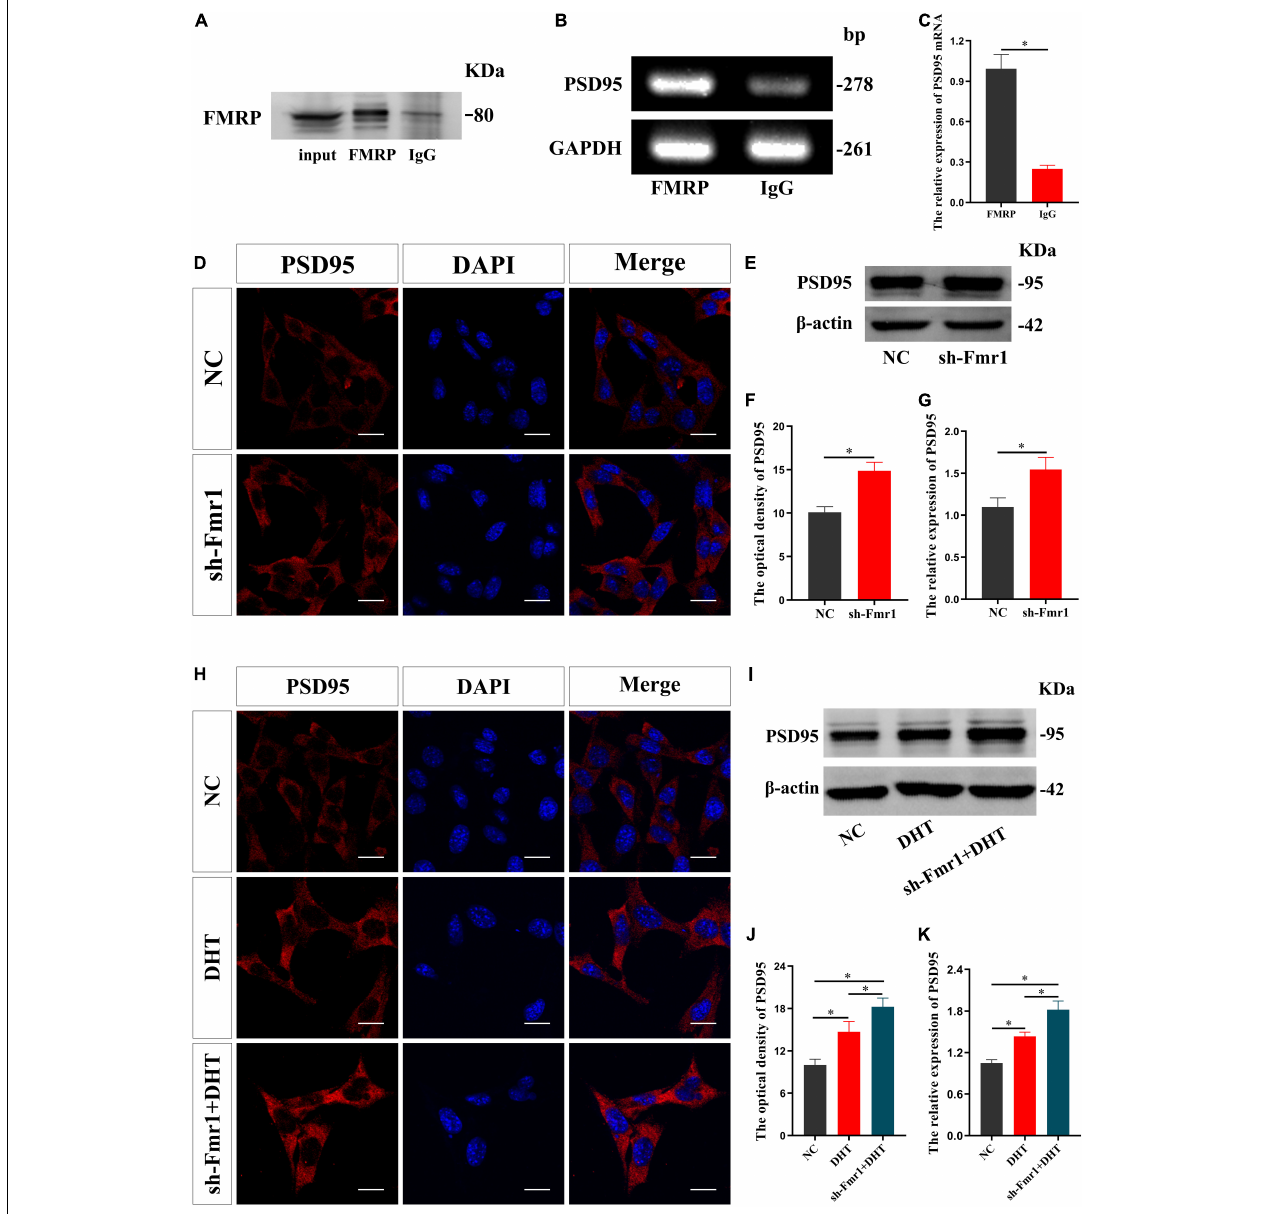
FIGURE 2 | FMRP regulates DHT-induced expression of PSD95 protein in HT22 cells. (A–C) RNA immunoprecipitation for the interaction between FMRP and PSD95 mRNA in HT22 cells. (D , F) Immunofluorescence cytochemistry for PSD95 expression in HT22 cells pre-treated with NC or sh-Fmr1. (E , G) Western blotting for PSD95 expression in HT22 cells pre-treated with NC or sh-Fmr1. (H , J) Immunofluorescence cytochemistry for PSD95 expression induced by DHT via FMRP in HT22 cells. (I , K) Western blotting for PSD95 expression induced by DHT via FMRP in HT22 cells. Scale bars = 20 µ m (* p < 0.05, n =